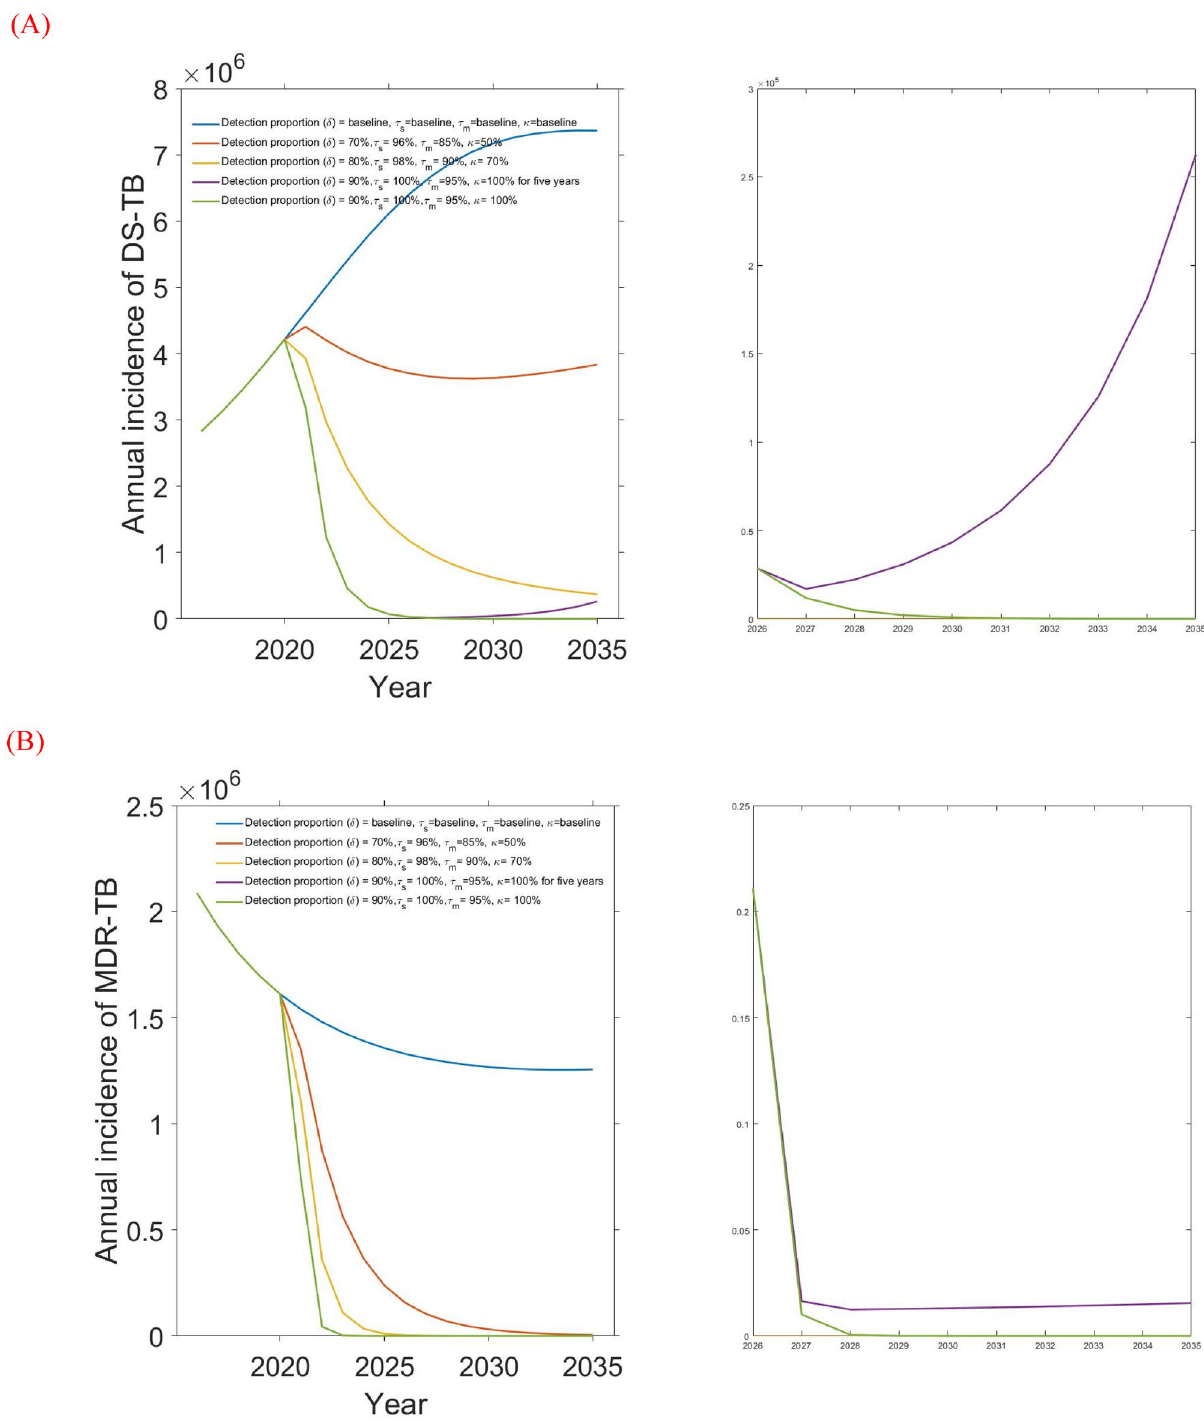
Figure 7. Combination intervention strategy and its effect on ( A ) DS-TB and ( B ) MDR-TB annual incidence in